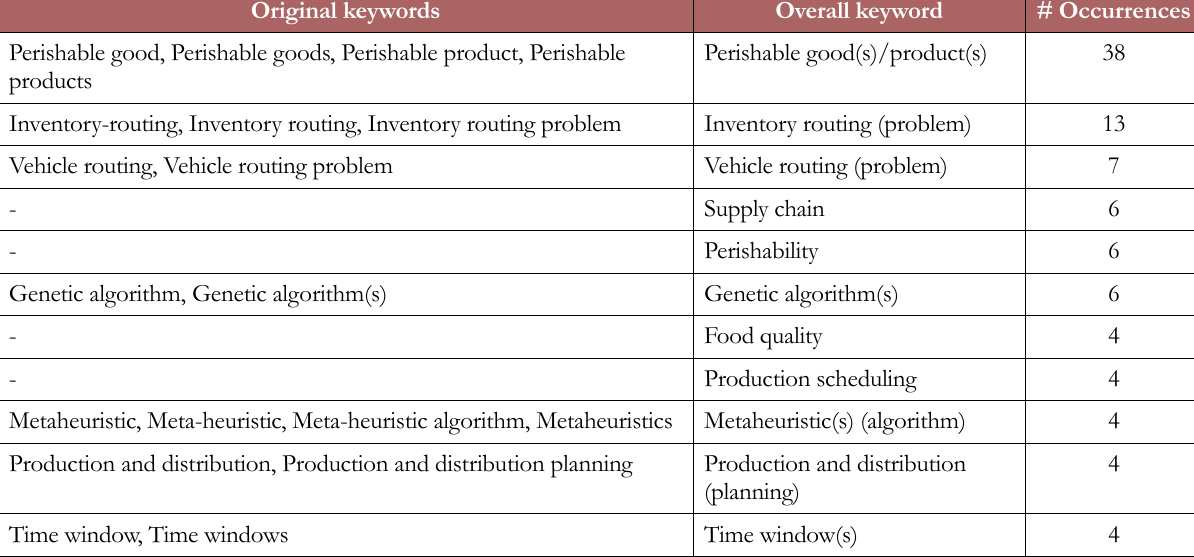
Table 6. Statistics on